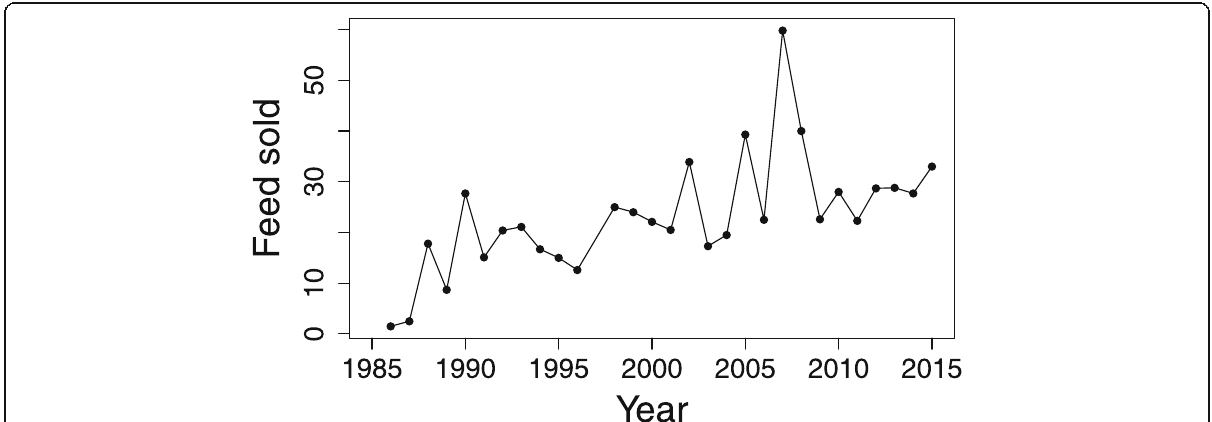
Fig. 4 Sale of factory-made reindeer feed in Sweden. Times series of the annual amount of factory-made reindeer feed (in kg per reindeer) sold by the two main producers in Sweden from 1986 to